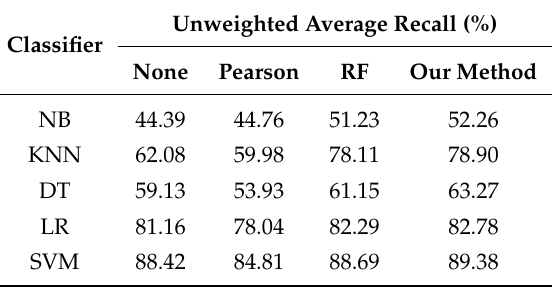
Table 6. Unweighted average recall of speaker-dependent emotion recognition on CASIA.